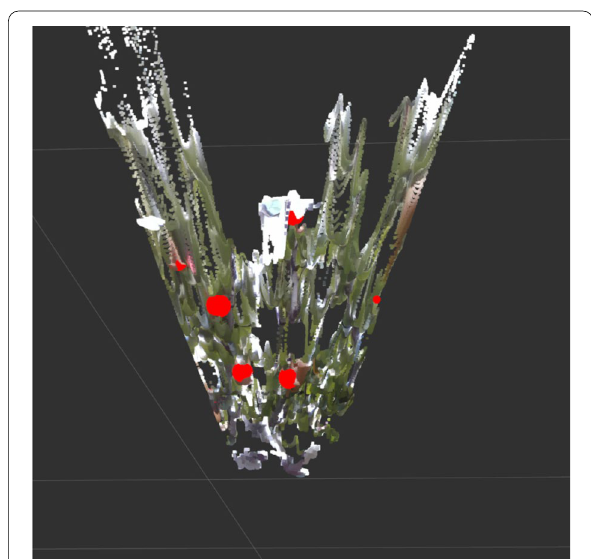
Fig. 10 Experimental fields